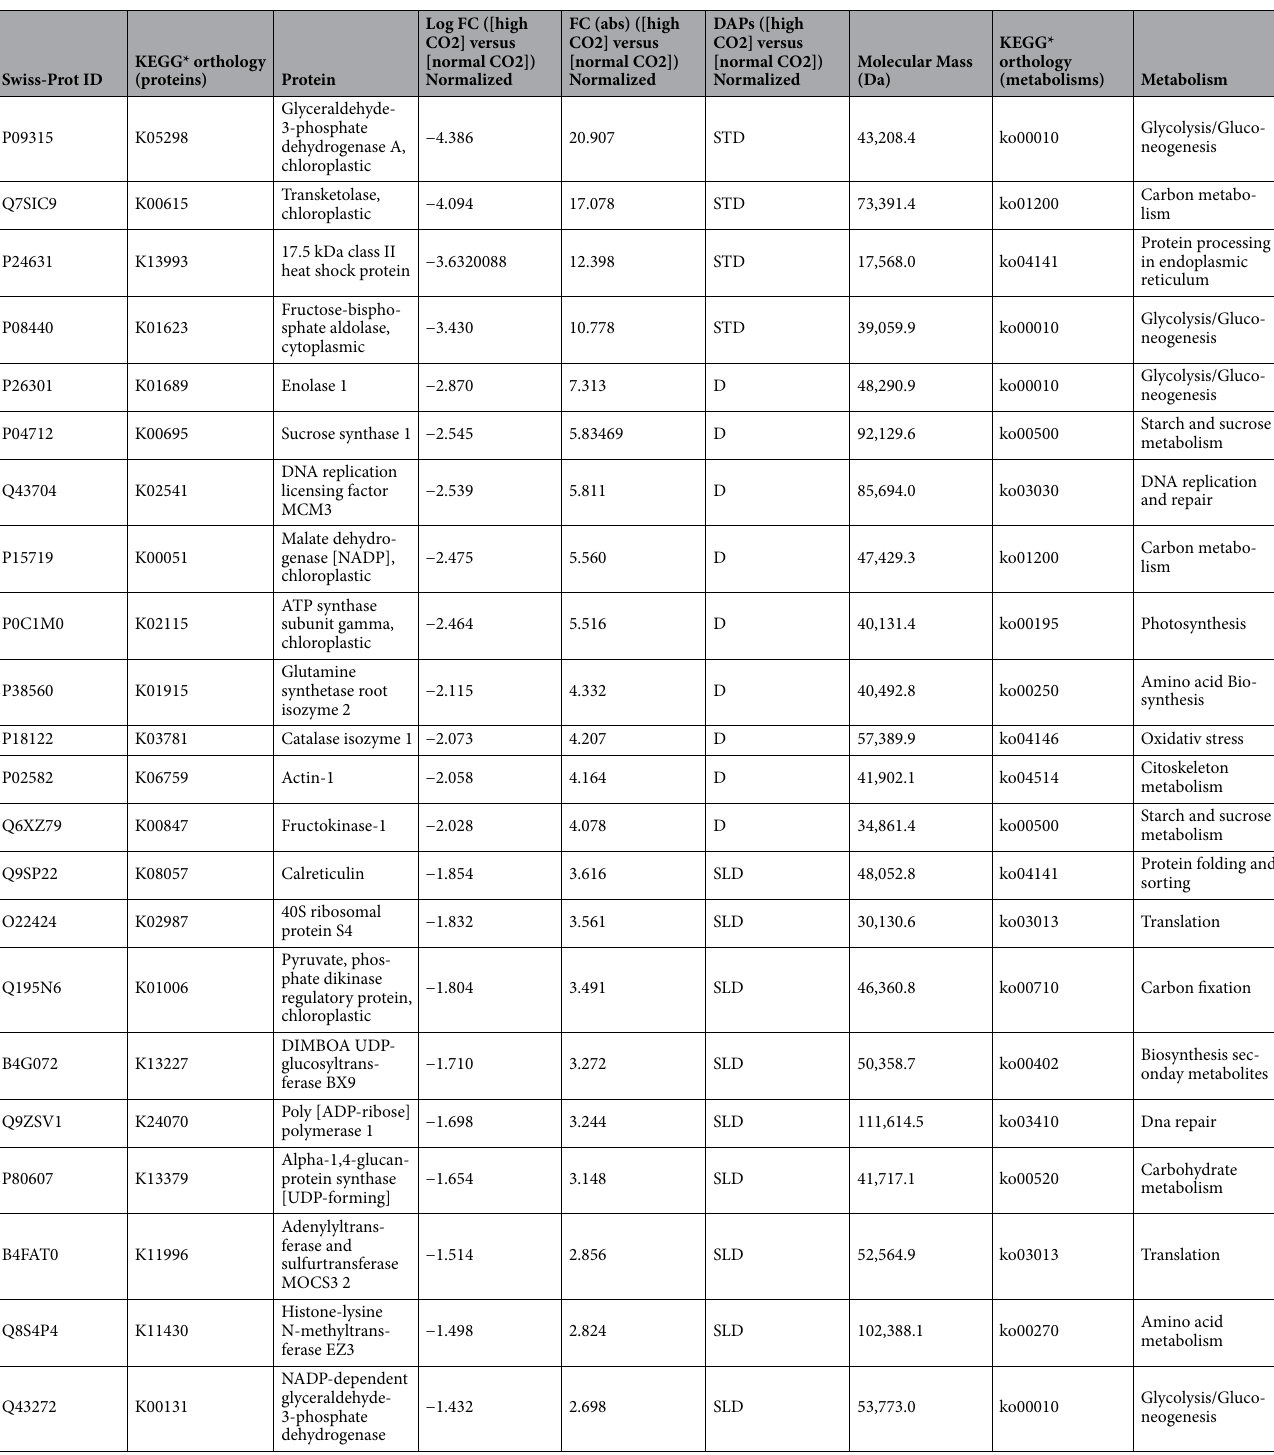
Table 1. Differential abundant proteins (DAPs) in leaf tissue of high p CO2 samples comparing with those of normal p CO2 samples. Accession number, protein name, fold change expressed as Log (2) and absorbance, protein behavior KEGG orthology, molecular mass and metabolisms have been shown. Strongly accumulated and strongly depleted proteins are reported in bold. Details on mass spectrometry parameters for peptides for each identified proteins are reported in the Supplementary Table 2 STA: Strongly accumulated; STD: Strongly depleted; A: accumulated; D: Depleted; SLA: Slightly accumulated; SLD: Slightly depleted * KEGG codes are developed in the Kanehisa